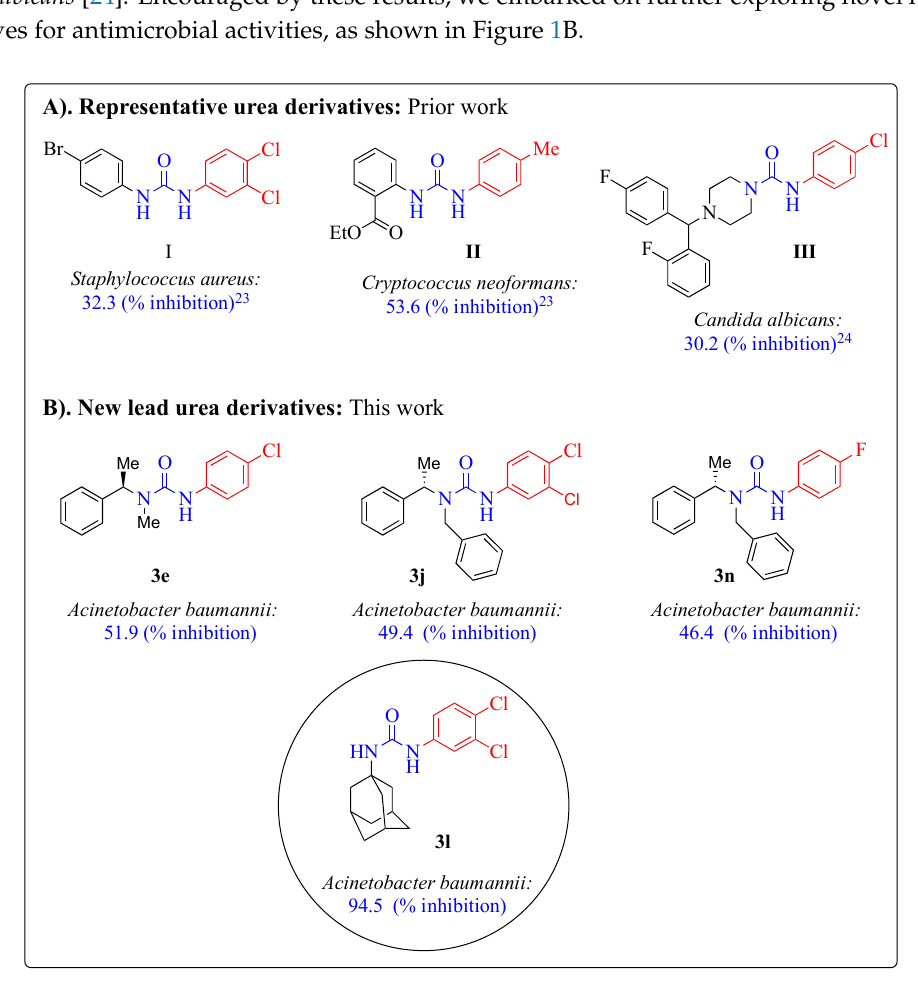
Figure 1. Antimicrobial urea Figure 1 . Antimicrobial urea derivatives.